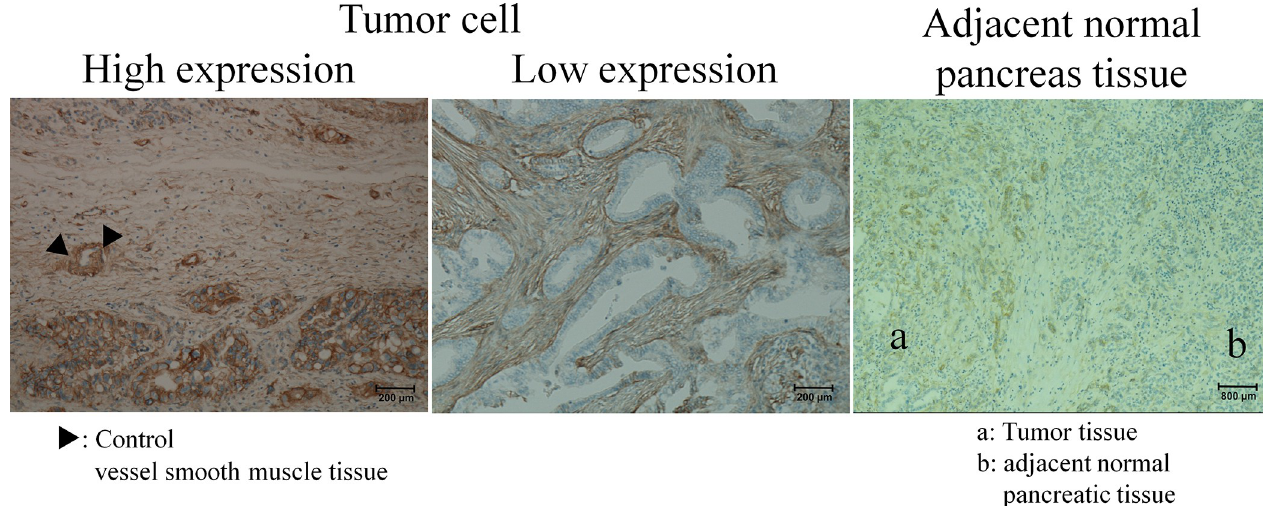
Fig 3. IHC of ITGB1 in pancreatic cancer tissue. For ITGB1 IHC analysis, the cell membrane and all vascular smooth muscle were stained in the positive control tissue. Staining levels in vascular smooth muscle were used as controls (Magnification = 160 X, 160 X, and 40 X, respectively).